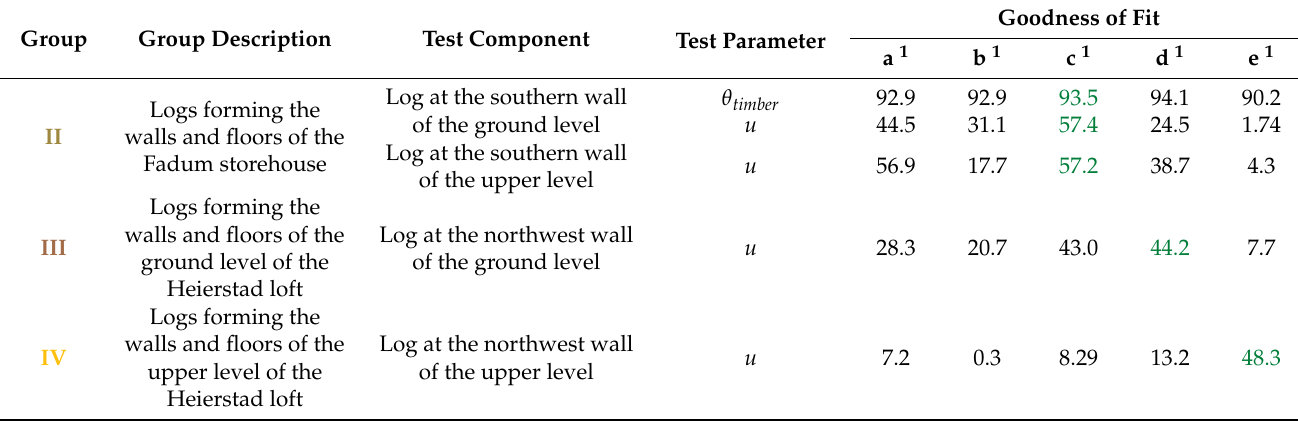
Table 5. Selection of material properties for the logs of the two case studies by examining the goodness of fit between measured and simulated hygrothermal